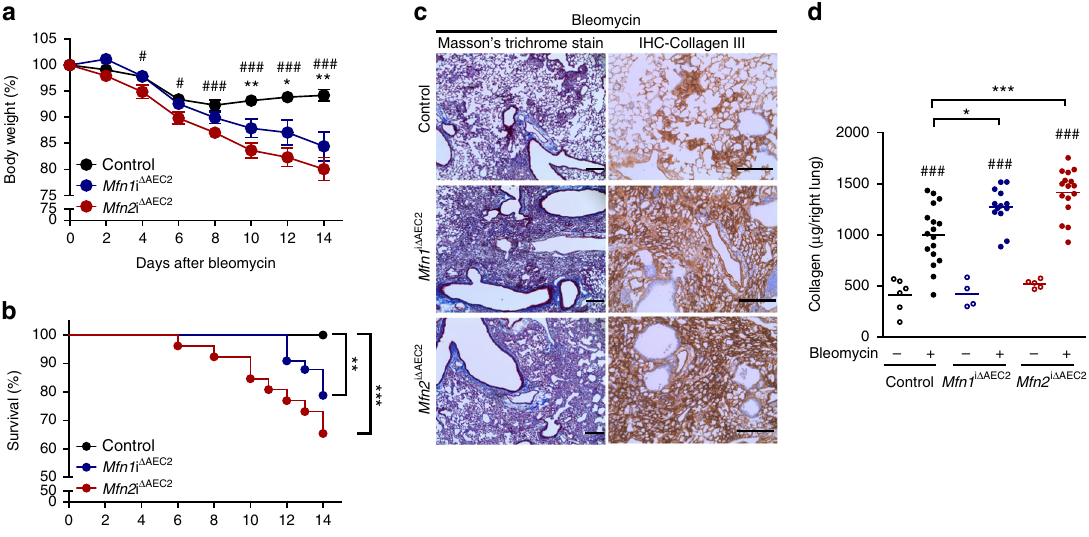
Fig. 4 MFN1 or MFN2 de fi ciency in AEC2 cells promotes bleomycin-induced lung fi brosis. a Body weight changes of control ( n = 18), Mfn1 i Δ AEC2 ( n = 13) and Mfn2 i Δ AEC2 ( n = 16) mice after bleomycin treatment. Data are mean±s.e.m. (results from 3 independent experiments; * Mfn1 i Δ AEC2 vs. control, # Mfn2 i Δ AEC2 vs. control; * and # , p < 0.05, ** and ## , p < 0.01, ### p < 0.001, by unpaired Student ’ s t test). b Kaplan – Meier survival curves of control ( n = 32), Mfn1 i Δ AEC2 ( n = 33) and Mfn2 i Δ AEC2 ( n = 26) mice after bleomycin treatment (results from 3 independent experiments; ** p < 0.01, *** p < 0.001, by log-rank test). c Masson ’ s trichrome staining (left panel, ×100 magni fi cation, scale bar 200 μ m) and IHC staining of collagen III (right panel, ×200 magni fi cation, scale bar 200 μ m) in lung sections of control, Mfn1 i Δ AEC2 and Mfn2 i Δ AEC2 mice14 days after bleomycin treatment (control mice n = 10, Mfn1 i Δ AEC2 mice n = 12, Mfn2 i Δ AEC2 mice n = 3). d Acid-soluble collagen levels in the right lung from control (PBS n = 6, bleomycin n = 17), Mfn1 i Δ AEC2 (PBS n = 4, bleomycin n = 13) and Mfn2 i Δ AEC2 (PBS n = 5, bleomycin n = 16) mice 14 days after PBS or bleomycin treatment, quanti fi ed by Sircol assay. The line indicates mean ( # , bleomycin vs. PBS, * vs. control mice; * p < 0.05, *** and ### p < 0.001 by one-way ANOVA with post-hoc Bonferroni